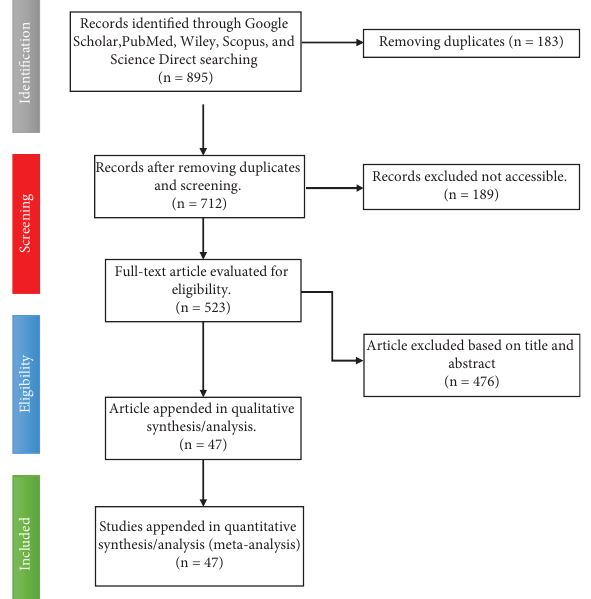
Figure 1: Flowchart illustrating the method for determining and including articles in the random efects